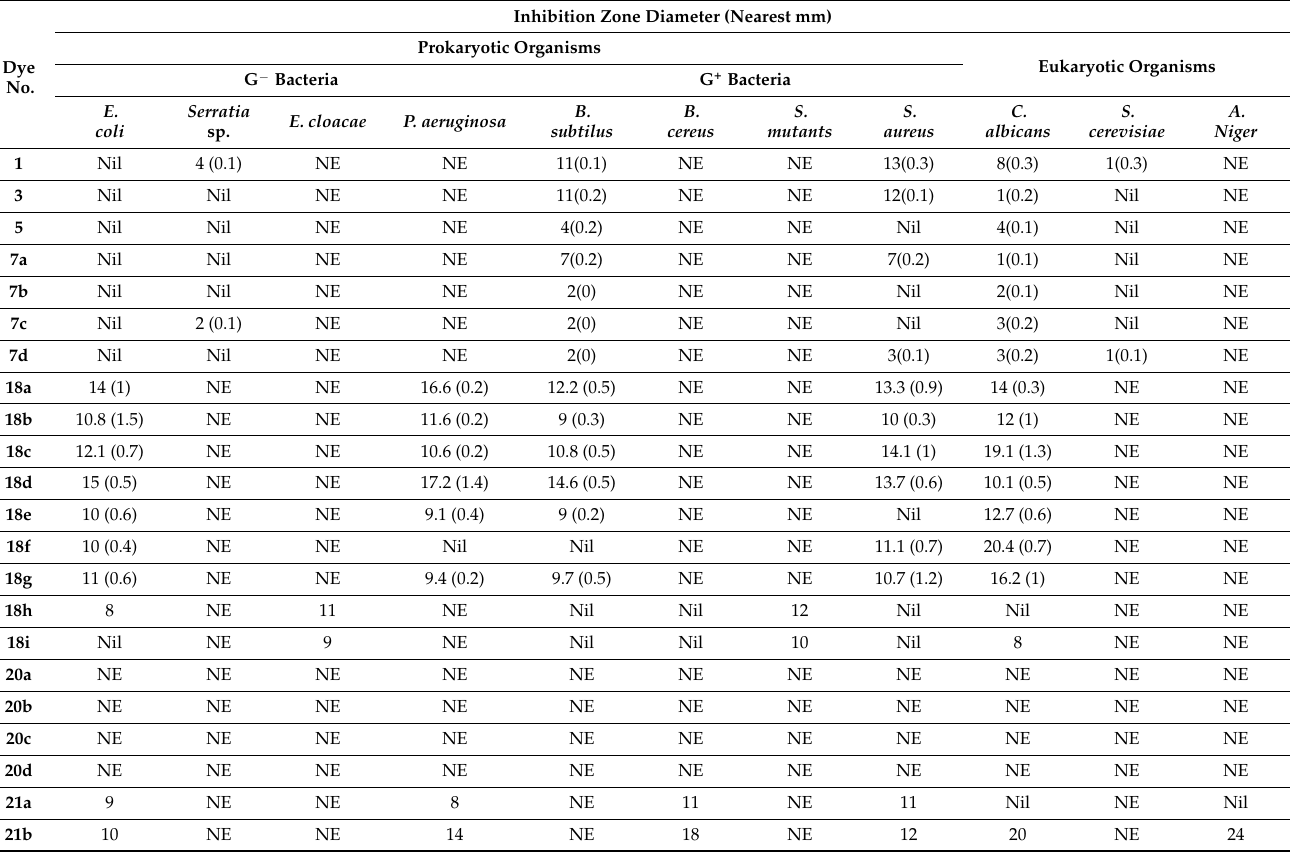
Table 5. Inhibition zones of the synthesized disperse dyes.